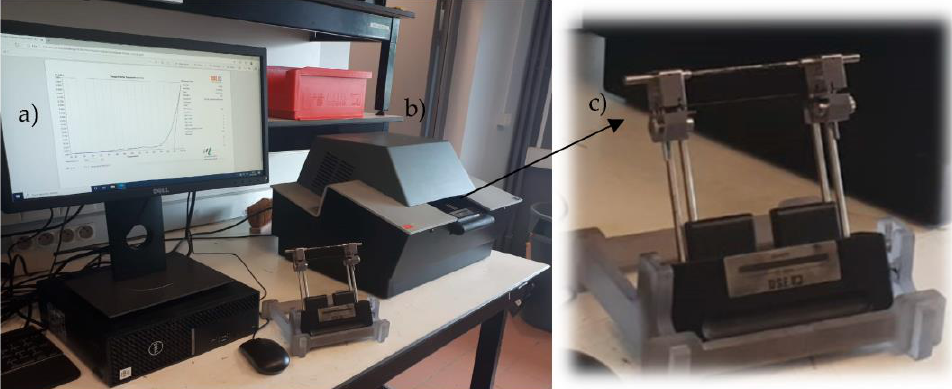
Figure 5. Dissipation factor measurement device: ( a ) Display of collected data; ( b ) Circulating air oven and, ( c ) sample with a graphite coat.